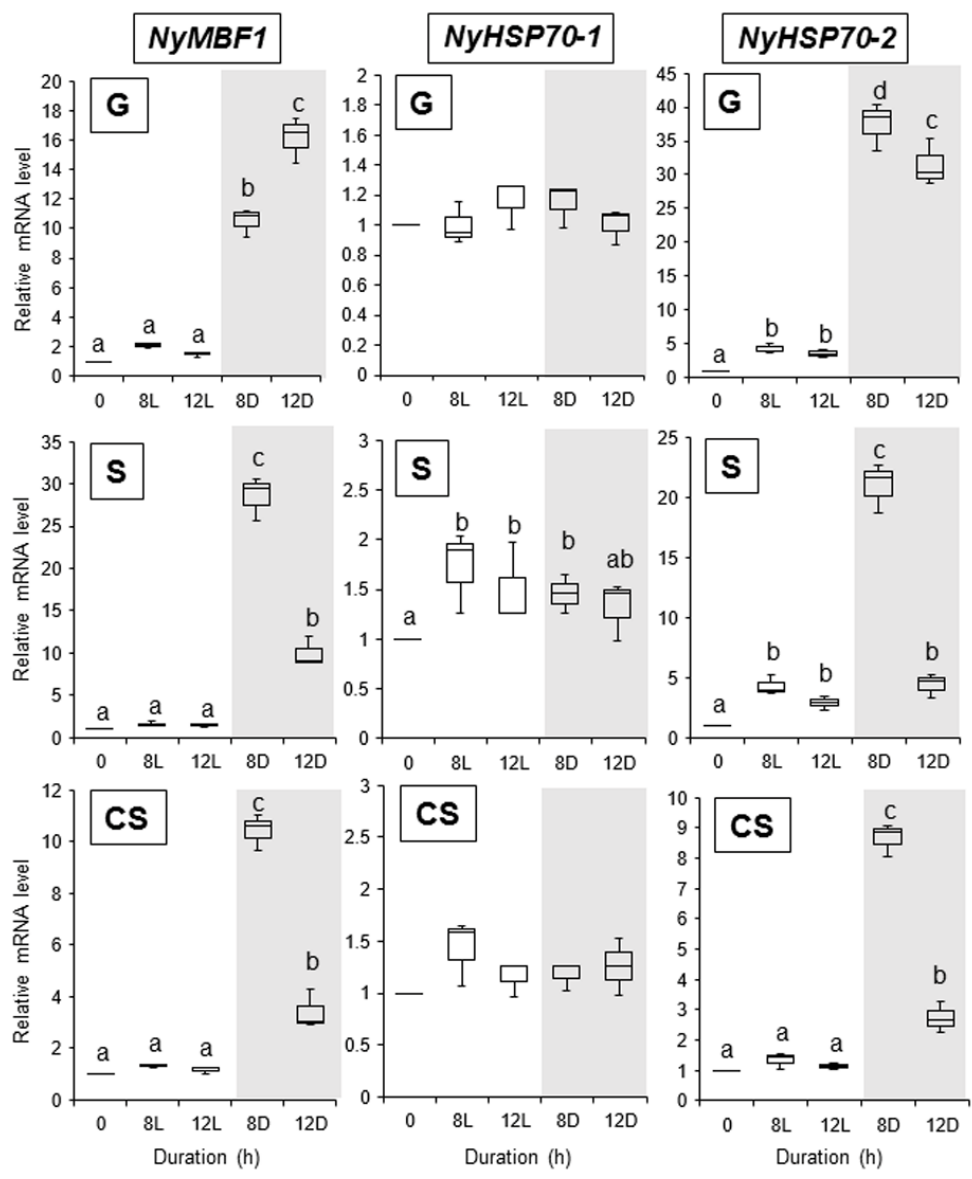
Figure 4. Effect of dark treatment on the second expression peak of NyMBF1 , NyHSP70-1 , and NyHSP70-2 in three life cycle generations of Neopyropia yezoensis at 25 °C. Gene expression in the light and dark, and at 8 and 12 h after heat stress exposure, were compared. Relative mRNA levels were normalized using eIF4A as the reference gene. In the box plots, values on the Y axis represent the fold change of relative quantification of each gene. Different alphabetical letters denote significant differences in expression level among the three life cycle generations from triplicate independent replicates as defined by Tukey’s test ( p < 0.05) in two-way ANOVA. L—light; D—dark; G—gametophyte; S—sporophyte; CS—conchosporophyte.